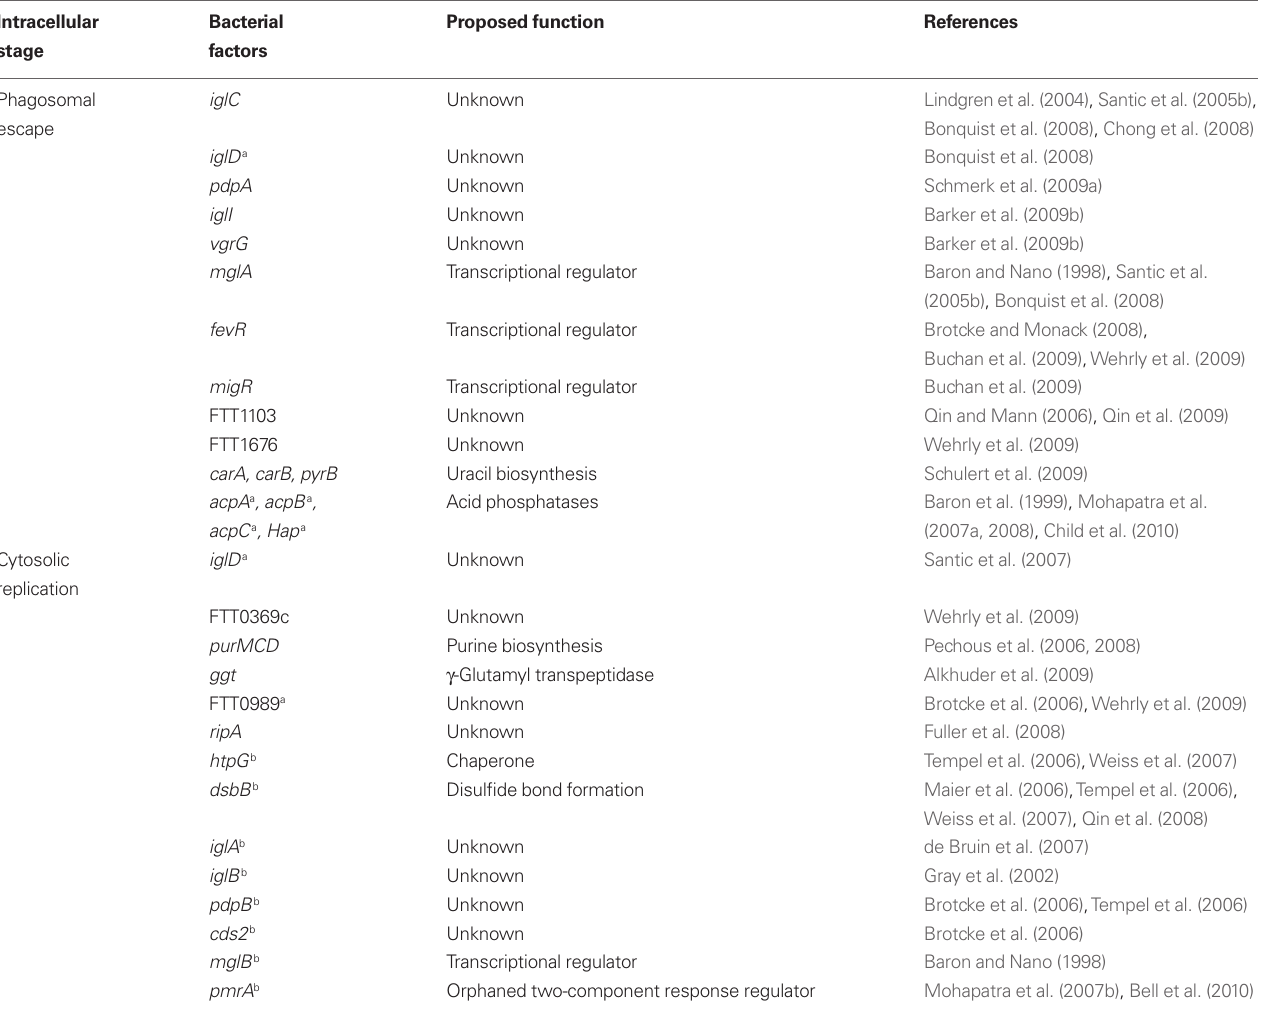
Table 1 | Bacterial factors that contribute to the Francisella intracellular